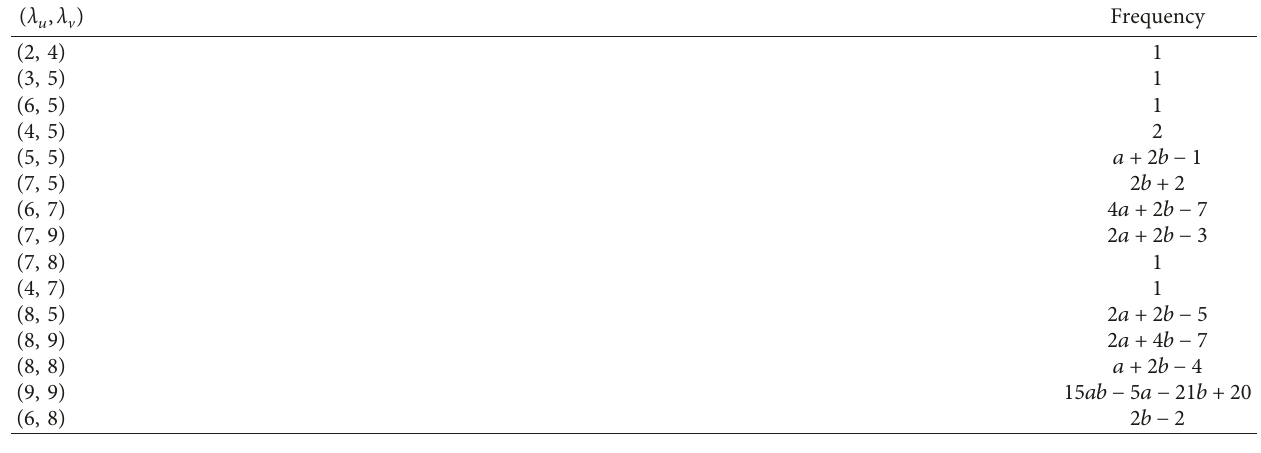
Table 13: The number of edges of Si